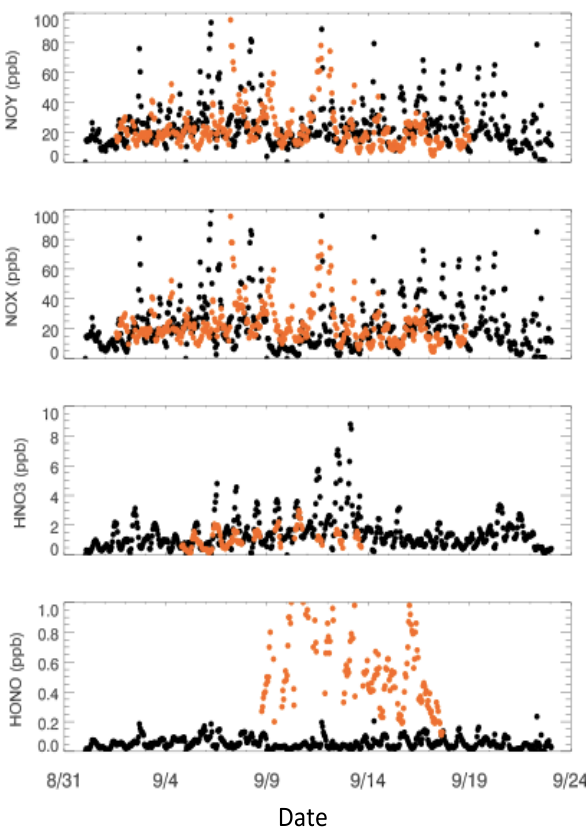
Fig. 5. The measured (orange dots) and calculated (black dots) tem- poral variability of VOC concentrations as alkanes, alkenes, aro- matics, and OVOCs at the PD